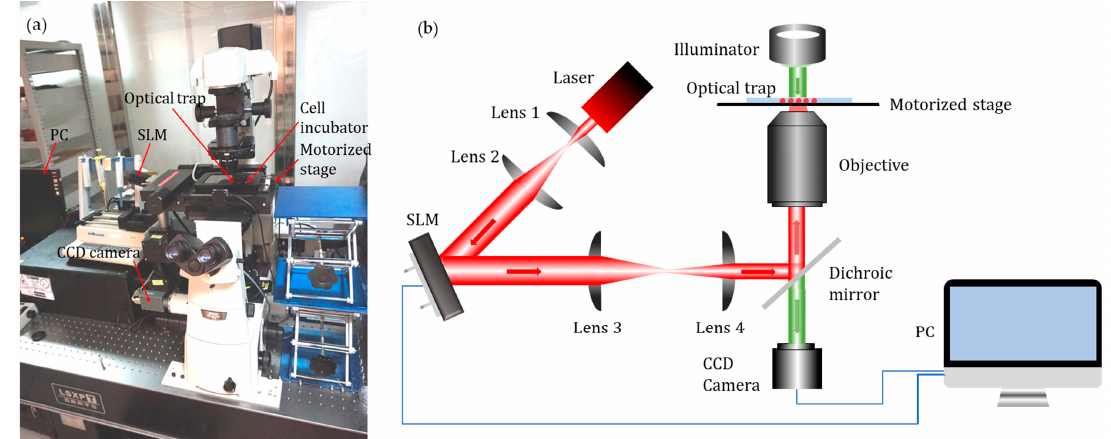
Figure 3. Robot-aided holographic optical tweezer (HOT) cell manipulation system. ( a ) Experimental setup. ( b ) Schematic illustration.